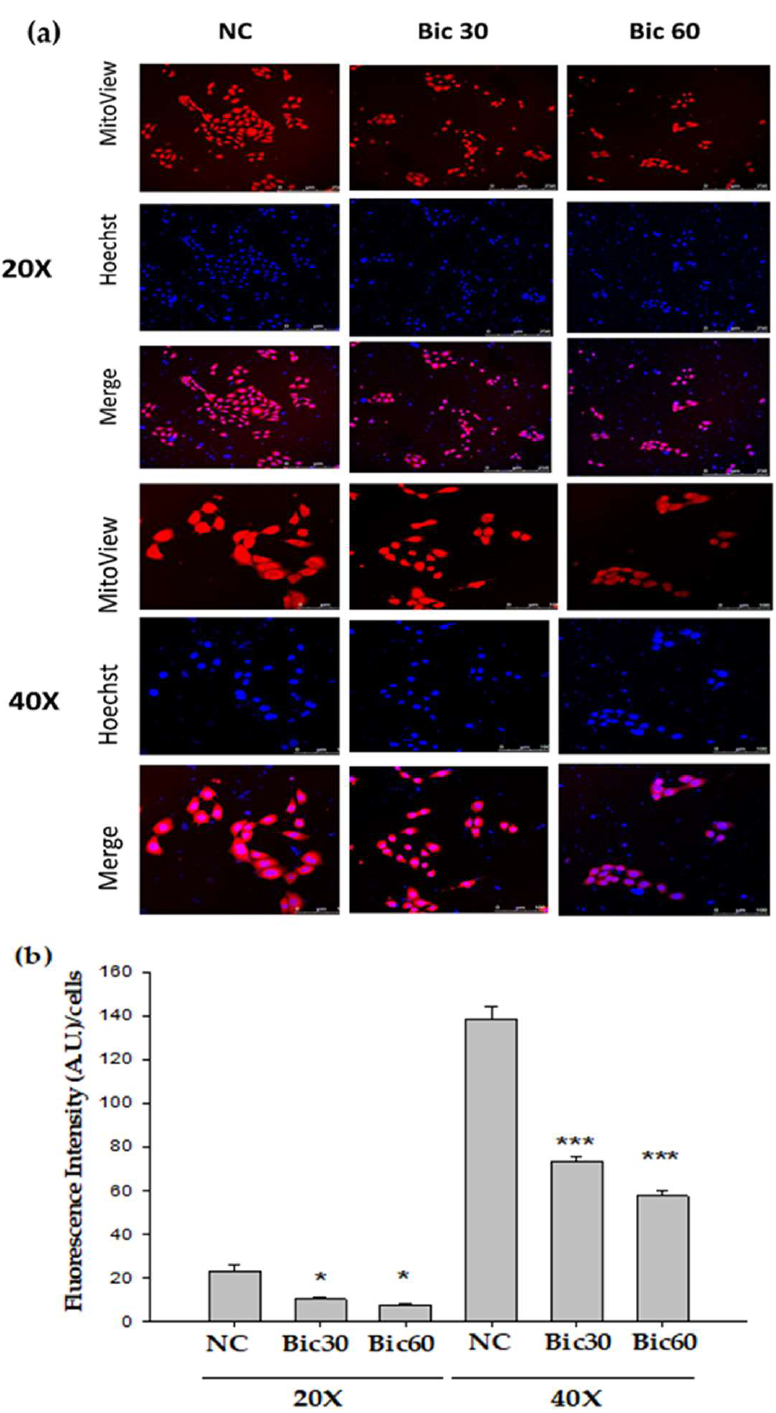
Figure 1. Mitochondrial membrane potential ( ∆ ψ m) monitored by Mitoview 633 ® in RMC cells decreased following Bicalutamide treatment. ( a ) RMC cells treated with Bicalutamide after 24 h were incubated with Mitoview 633 ® (red color) for 15 min, 37 ◦ C. Hoechst 33342 was used to stain nuclei (blue color). ( b ) The quantified bar diagram from images analyzed by fluorescence microscopy. ( n = 3, NC: normal control, Bic 30, 60: bicalutamide 30 µ M and 60 µ M. Magnification: 20 × for upper three panels, 40 × for lower three panels. * p < 0.05, *** p < 0.001 compared to NC).